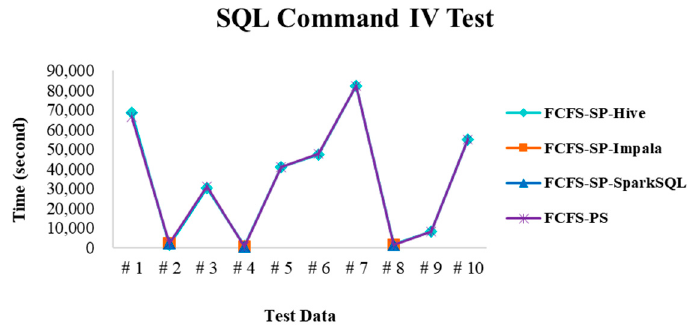
Figure 17. Execution time of SQL command III in test environment I.